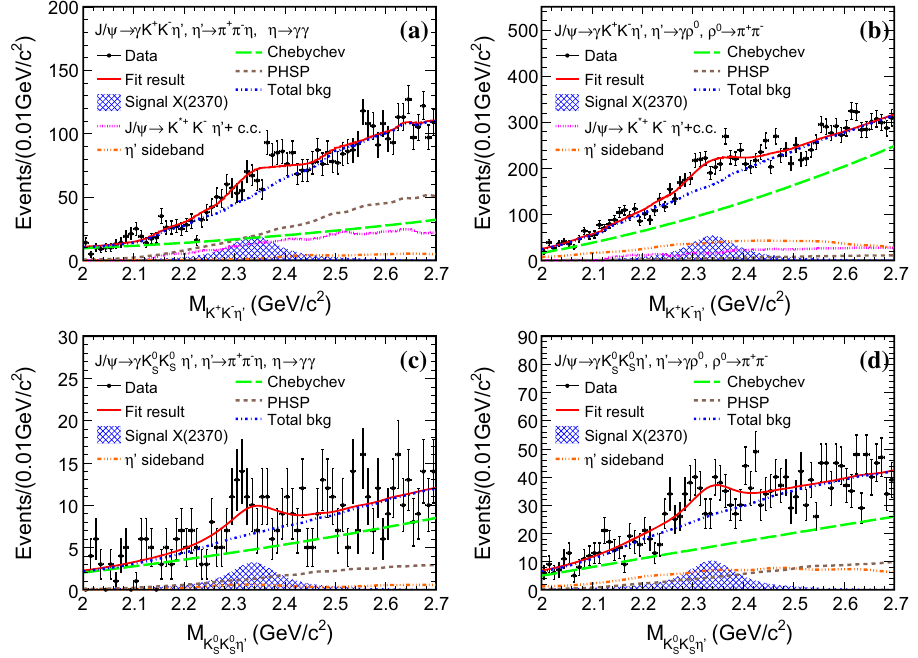
Fig. 3 The fit result for X ( 2370 ) in the invariant-mass distribu- show the fit results; the grid areas represent the signal of X ( 2370 ) ; the tion of K ¯ K η (cid:3) for the decays: a J /ψ → γ X ( 2370 ), X ( 2370 ) → dotted lines are the background shapes from J /ψ → K ∗+ K − η (cid:3) + c . c . ; γ K + K − η (cid:3) ,η (cid:3) the short dashed double dotted lines show the η (cid:3) sidebands; the long dashed lines represent the Chebychev polynomial function; the gray η (cid:3) ,η (cid:3) → π + π − η , η → γγ , J /ψ → γ X ( 2370 ), X ( 2370 ) → γ K 0 K 0 short dashed lines are the contribution from PHSP MC and the dashed S S η (cid:3) ,η (cid:3) → γρ 0 ,ρ 0 → dotted lines show the sum of all backgrounds K 0 and d J /ψ → γ X ( 2370 ), X ( 2370 ) → γ K 0 S S π + π − . The dots with error bars represent the data; the solid curves